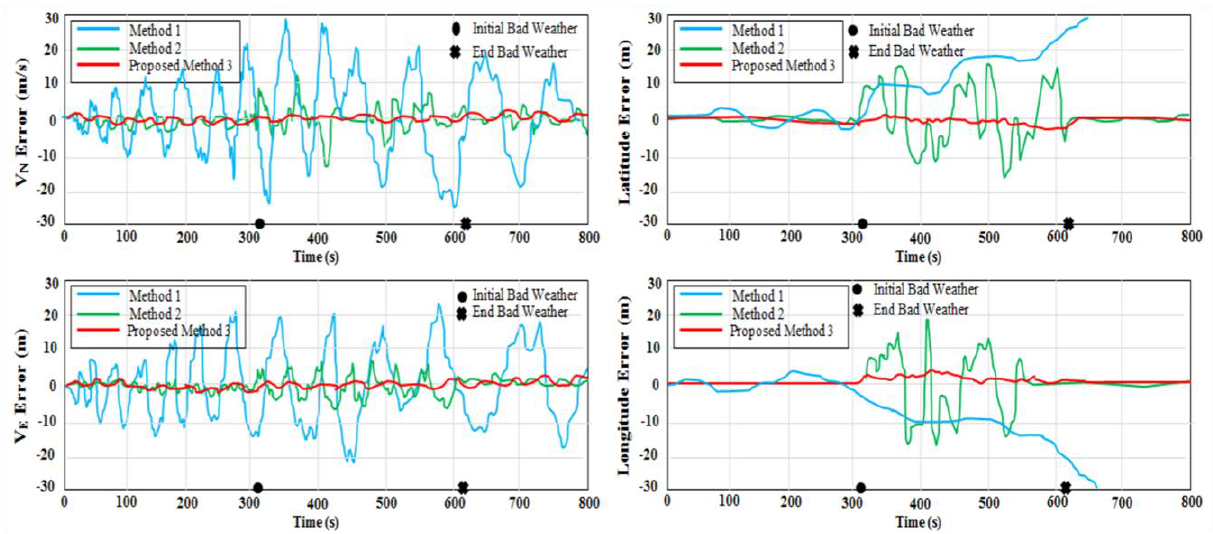
Figure 9. Estimated Errors with the Three Integrated Methods.